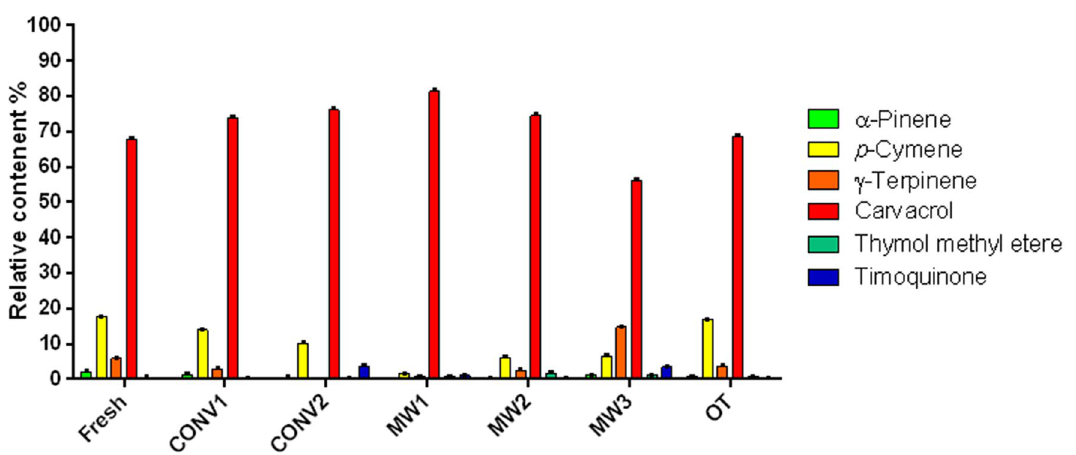
Figure 4. Percentage of major components of O. vulgare essential oils obtained by different